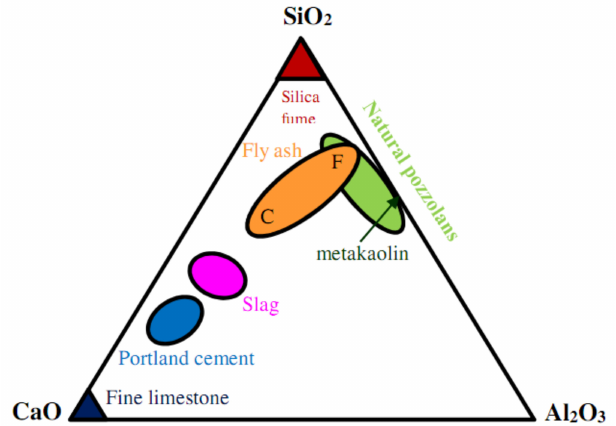
Figure 6. Ternary diagram of supplementary cementitious materials (SCMs) [67]. Reprinted with permission from Elsevier